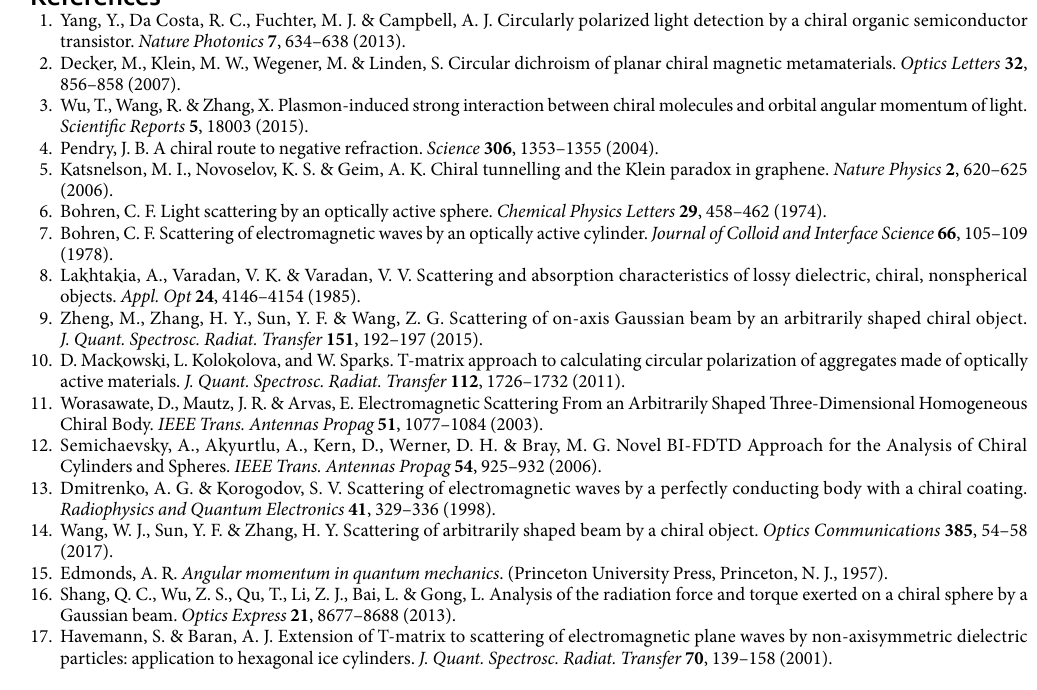
Based on a combination of the EM field expansions in infinite series of the spherical VWFs with the MoM scheme, a semi-analytical solution of the EM beam scattering from a chiral-coated conducting object is proposed. By taking as examples an incident Gaussian beam, VPW, ZOBB and HED radiation striking a chiral-coated conducting spheroid and finite-length circular cylinder, the normalized DSCS is calculated. The correctness of the present theory to a certain extent is validated by comparing the normalized DSCS for a conducting spheroid, either with a chiral or dielectric coating, illuminated by a Gaussian beam with those obtained by the GLMT that gives an exact analytical solution. Theoretically, the present MoM based scheme can be used to treat arbitrary EM beam scattering given their explicit expressions, even extended to an infinite cylinder when appropriate cylindri- cal VWFs are chosen as the basis and weighting functions.